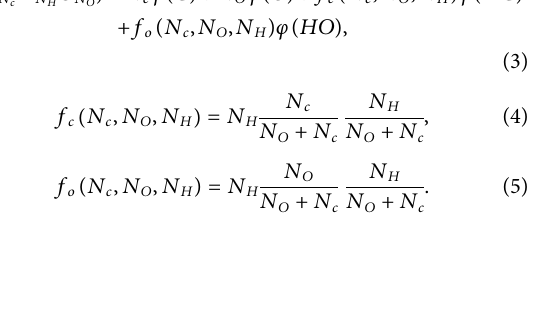
FIGURE 2 φ ( C H O ) is the spectroscopy of a PMMA ( C 5 8 2 molecule irradiated by a proton beam. φ ( C ) and φ ( O ) are spectroscopies directly generated by C ( p , γ ) C * and O ( p , γ ) O *, respectively. At the same time, neutrons come from the interaction of C ( p , n ) C * or O ( p , n ) O *. φ ( H ) is from the neutron absorption reaction H ( n , γ ) H